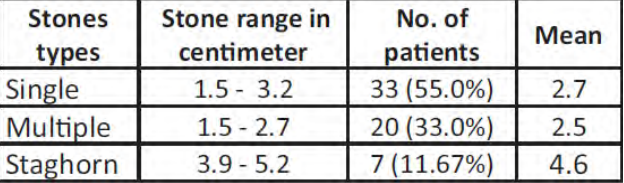
Table 1 . Distribution of type of stone and its